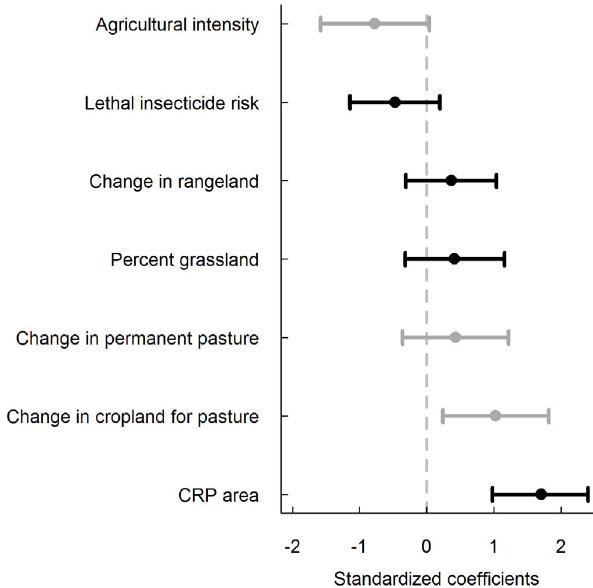
Figure 1. Model-averaged coefficients of covariates used to predict grassland breeding bird trends (1980–2003). Model- averaged coefficients (95% confidence intervals) occurring in the confidence sets of model suites one (gray bars) and two (black bars) that describe agricultural practices and habitat availability used to predict grassland breeding bird trends from 1980 to 2003 in the U.S. lethal insecticide risk (Table 2). Comparing only univariate models, the CRP model had . 2300 times more support than the lethal insecticide risk model. CRP had approximately 3.06 times the effect (ratio of standardized regression coeffi- cients = 1.71/0.47) on grassland bird populations than did lethal insecticide risk.